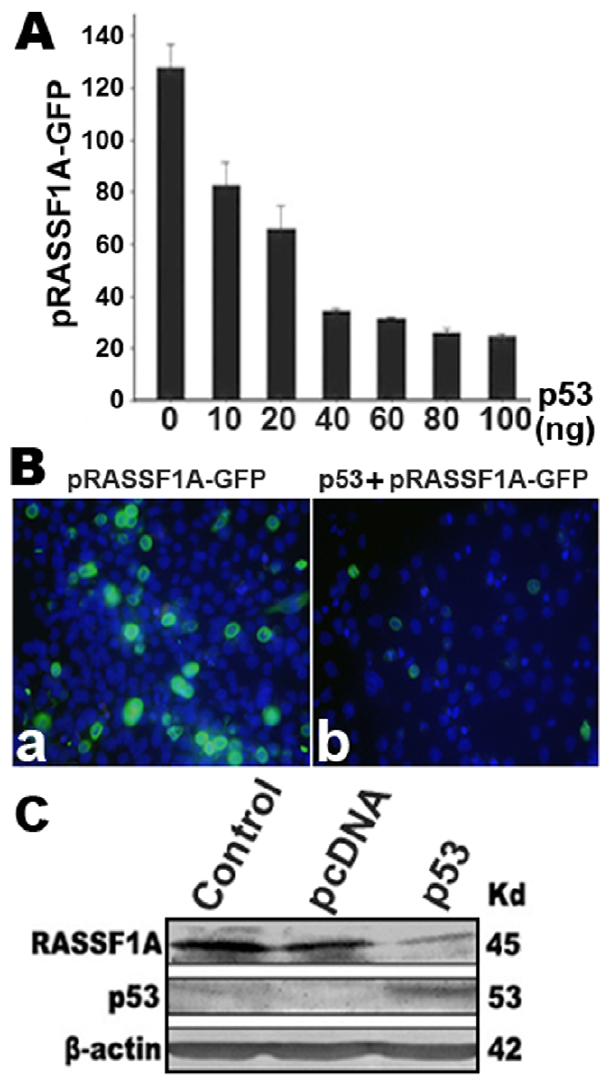
Figure 4. Down-regulation of RASSF1A by p53. A , RASSF1A promoter activity was inhibited by p53 protein with a dose dependent manner. pRASSF1A-GFP (construction c in Fig. 1) was co-transfected with different concentration of CMV-p53 into COS-7 cells, and transfected cells were analyzed by the flow cytometry. B , pRASSF1A- GFP was transfected into COS-7 cells ( a ) or co-transfected with p53 ( b ), and images were taken under fluorescent microscopy. p53 remarkably decreased expression of RASSF1A-GFP. GFP was mainly expressed in the cytoplasm. Nuclei were stained with Hoechst. C , Overexpression of p53 in Siha cells decreased RASSF1A protein levels, revealed by Western blot analysis of RASSF1A and p53 expression using anti-RASSF1A or p53 antibody after transfection of the p53 expression plasmid into Siha cells. Lysates of non-transfected cells and cells transfected with the pcDNA3 vector were used as controls. b -actin was used as an internal control. Molecular weights of the proteins are shown on the right.